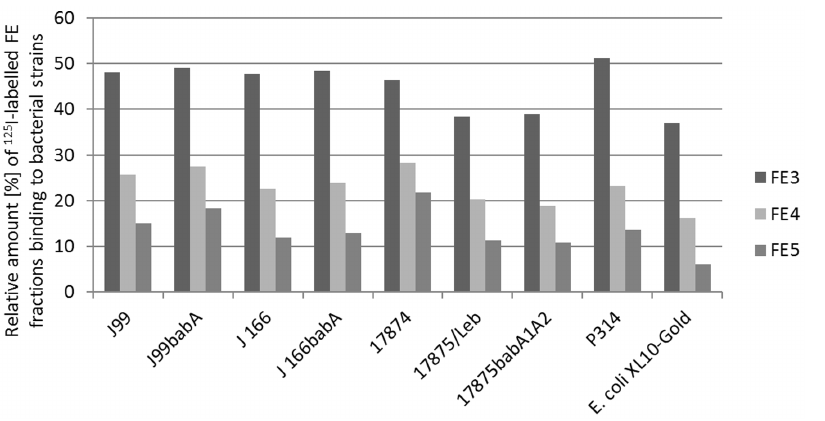
Figure 3. Binding of radiolabeled fractions Okra FE subfractions FE3, 4 and 5 to different H.pylori bacterial strains and E.coli reference strain.